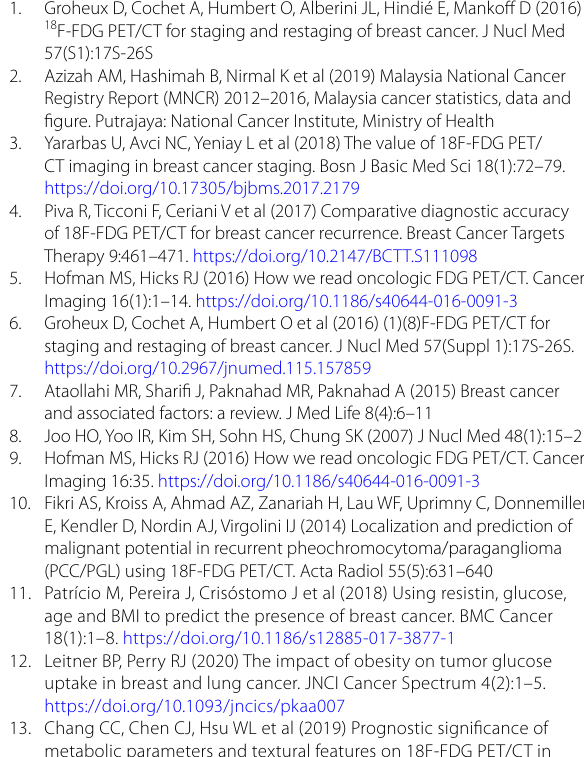
figure. Putrajaya: National Cancer Institute, Ministry of Health 3. Yararbas U, Avci NC, Yeniay L et al (2018) The value of 18F-FDG